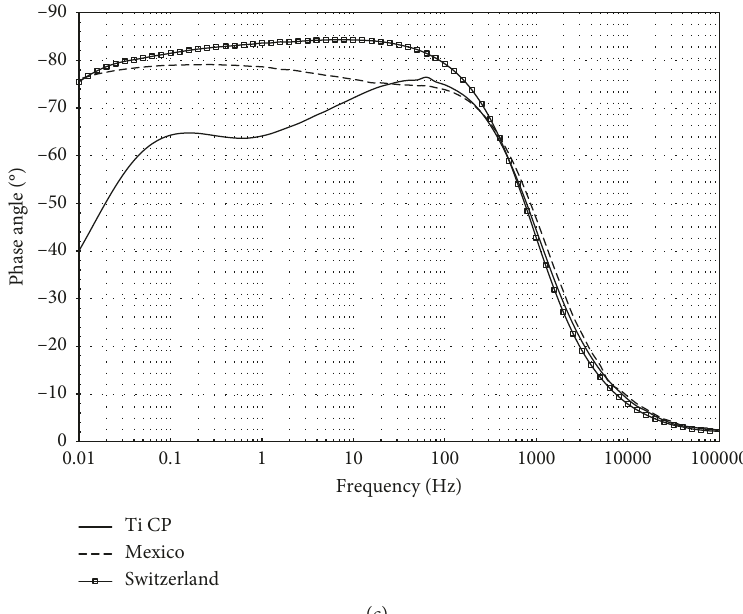
Figure 8: Electrochemical impedance spectra of nonalloyed Ti biomaterials after 100 hours of immersion in a 0.9% NaCl solution at 37 °